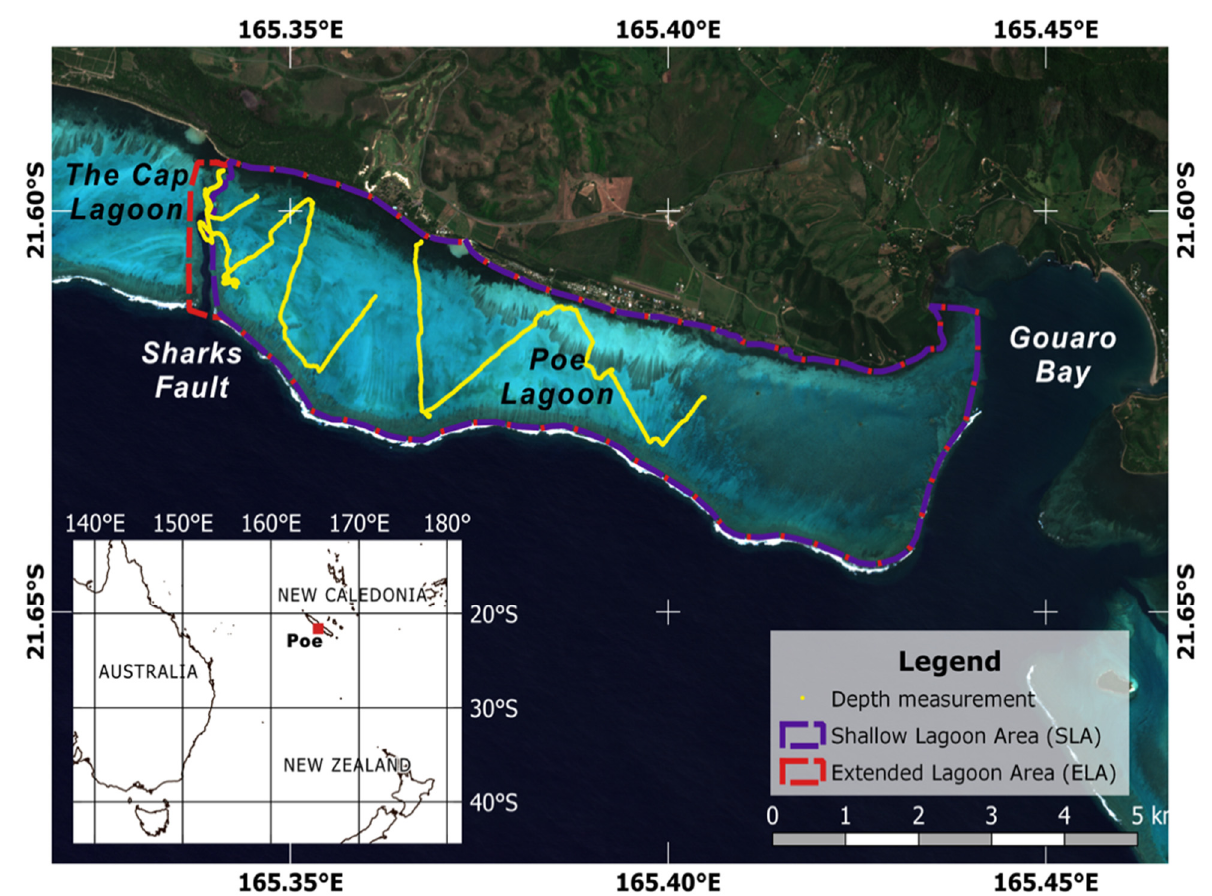
Figure 1. Location of the study site (red dot on the lower-left thumbnail). Sentinel-2 image of the Poe lagoon (5 March 2018), including toponyms, tracks of in situ depth soundings (yellow dots), limits of the shallow lagoon area (purple) and the limit of the extended area that includes the Sharks Fault pass (red).